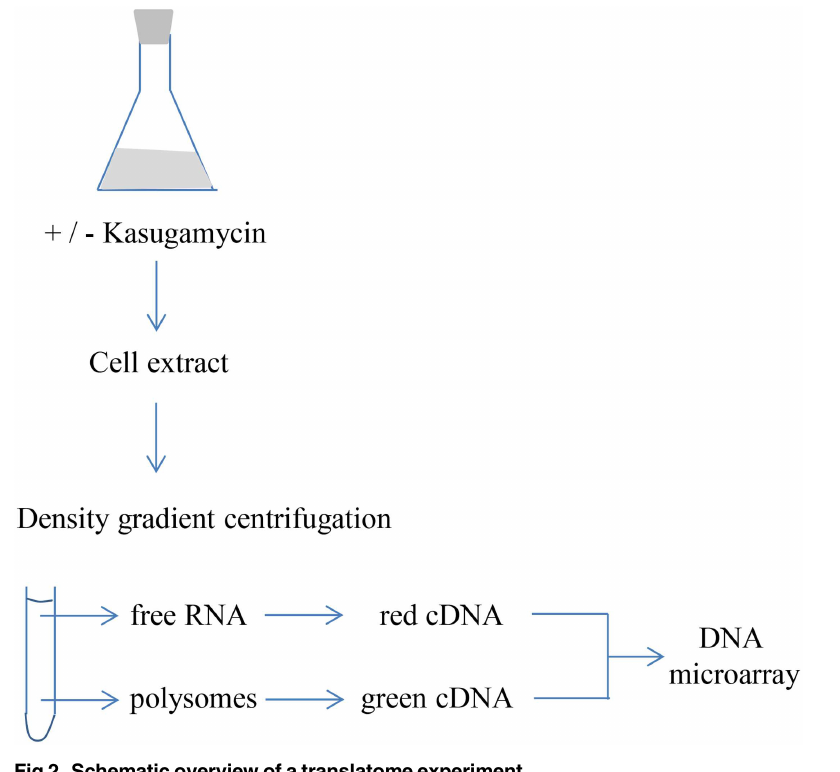
Fig 2. Schematic overview of a translatome